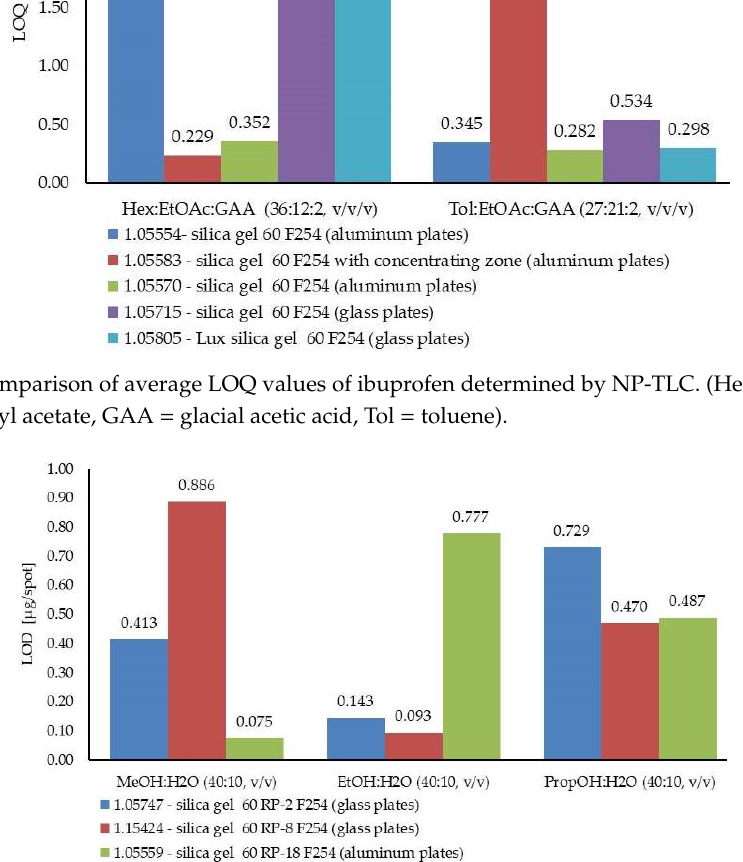
Figure 6. Comparison of average LOD values of ibuprofen determined by RP-TLC. (MeOH = methanol, EtOH = ethanol, PropOH = propan-1-ol).